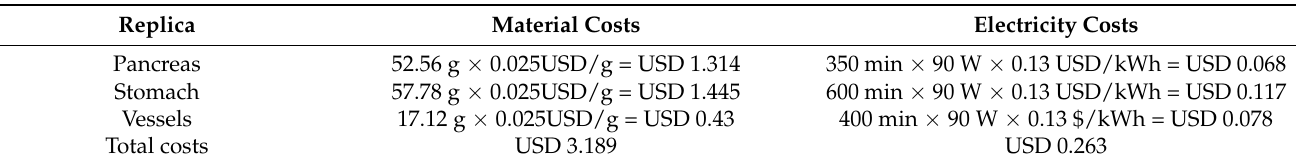
Table 1. Material and electricity costs for the finished printed replica.